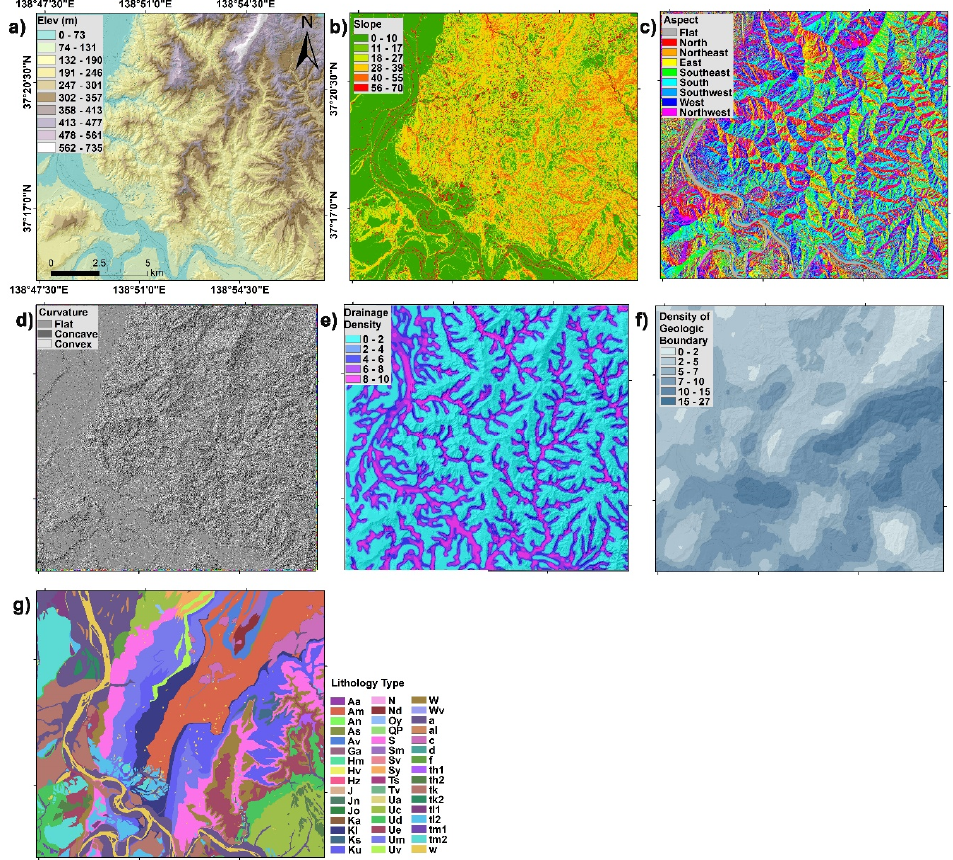
Figure 5. Landslide causative factors maps in this study: ( a ) elevation, ( b ) slope angle, ( c ) slope aspect, ( d ) plan curvature, ( e ) drainage density, ( f ) density of geologic boundaries, ( g ) lithology.